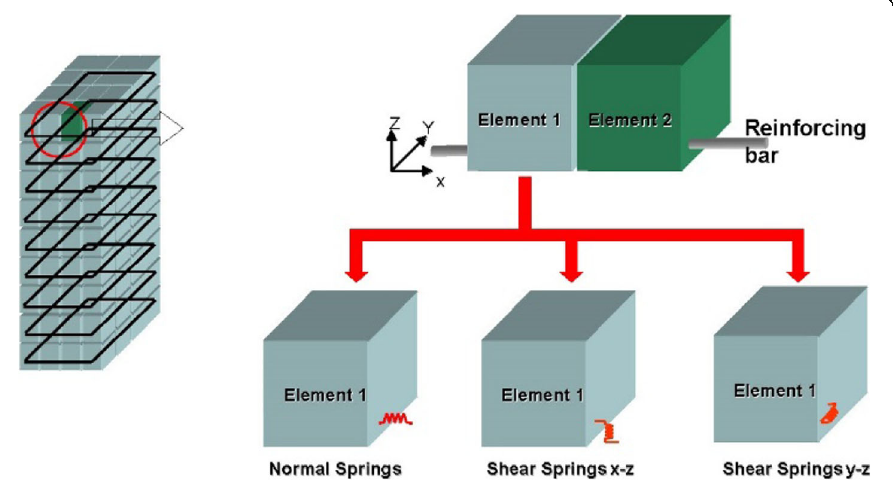
Fig. 4 Reinforcement springs [20] (color should be used for this